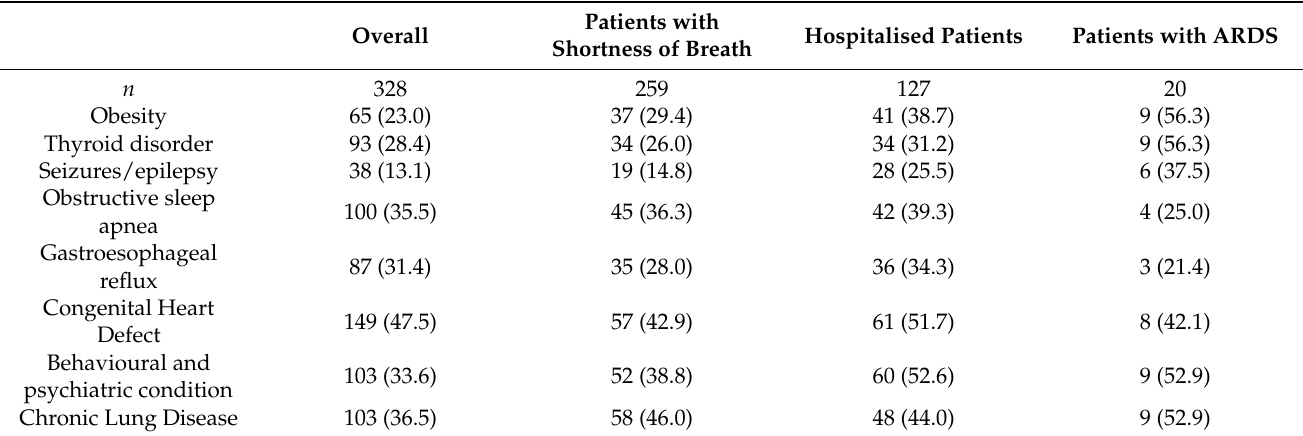
Table A7. Comorbidities reported by the T21RS